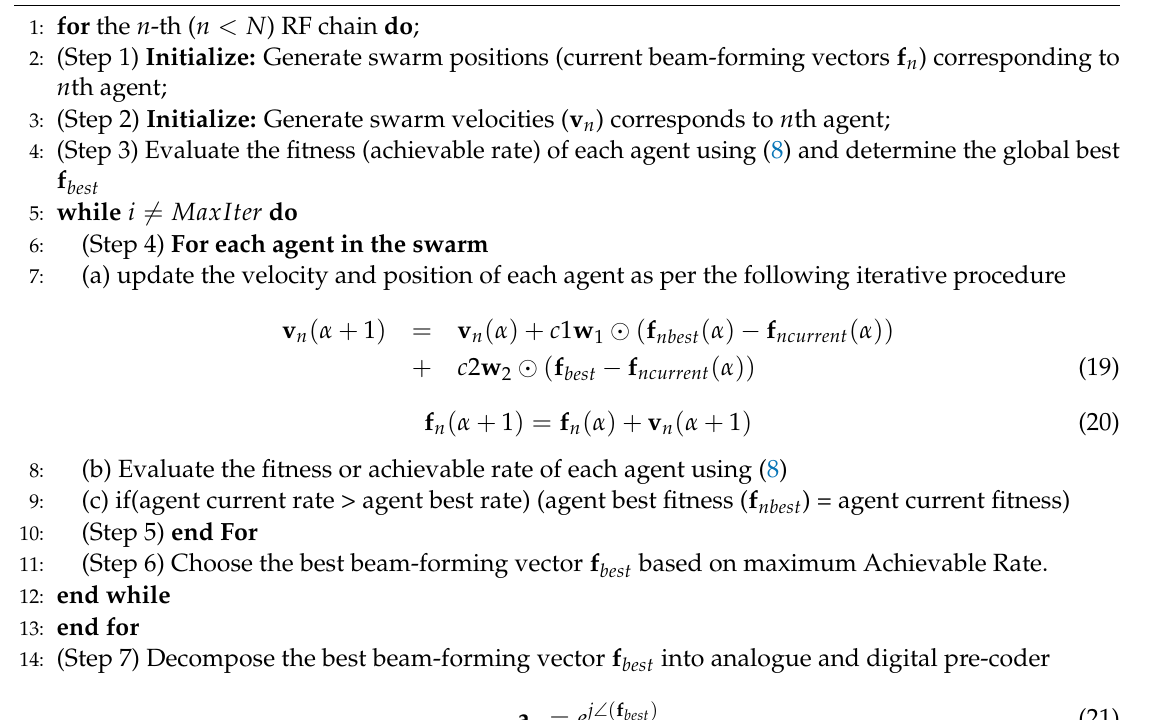
Algorithm 2 Particle Swarm Optimization